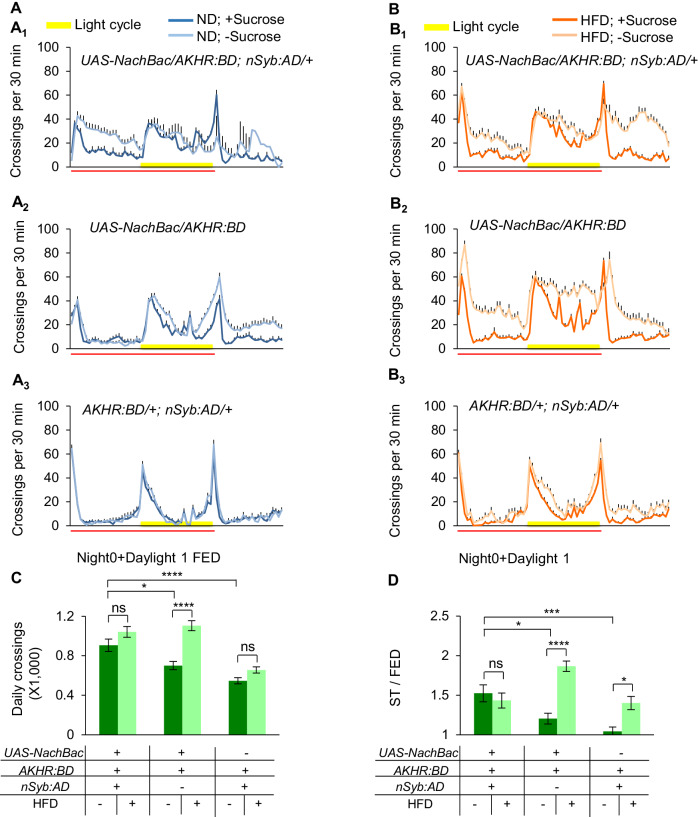
Activation AKHR+ neurons enhances starvation-induced hyperactivity under ND feeding.(A–B) Midline crossing activity of indicated genotypes and diet treatments assayed in the presence or absence of 5% sucrose (n = 30–61). Red line indicates the time window for quantifying average midline crossing activity. (C) Average daily midline crossing activity of fed flies assayed in A-B. (D) Starvation-induced hyperactivity of flies assayed in A-B. ns, p>0.05; *p<0.05; ***p<0.001; ****p<0.0001. One-way and two-way ANOVA followed by post hoc test with Bonferroni correction were used for multiple comparisons when applicable.